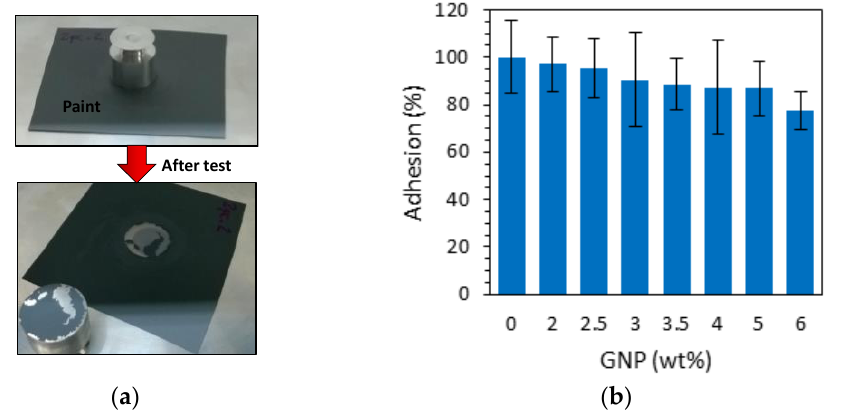
Figure 10. Adhesion strength between the coating and the substrate as a function of the GNP concentration: ( a ) picture of a sample before and after the test; ( b ) adhesion as a function of GNP content in the paint.